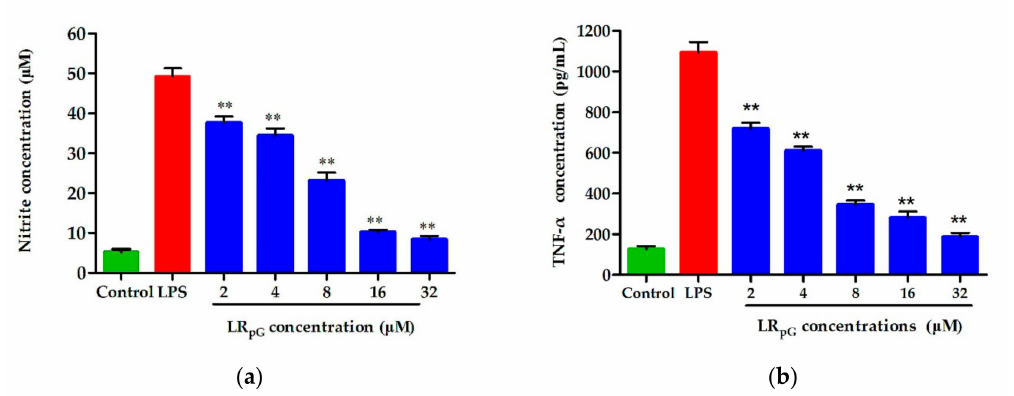
Figure 10. E ff ects of LR pG on the production of ( a ) nitric oxide (NO) and ( b ) tumor necrosis factor α (TNF- α ) in LPS-stimulated RAW 264.7 cells. The diagrams are based on the average of three independent experiments. ** p < 0.01, compared to the positive group (only